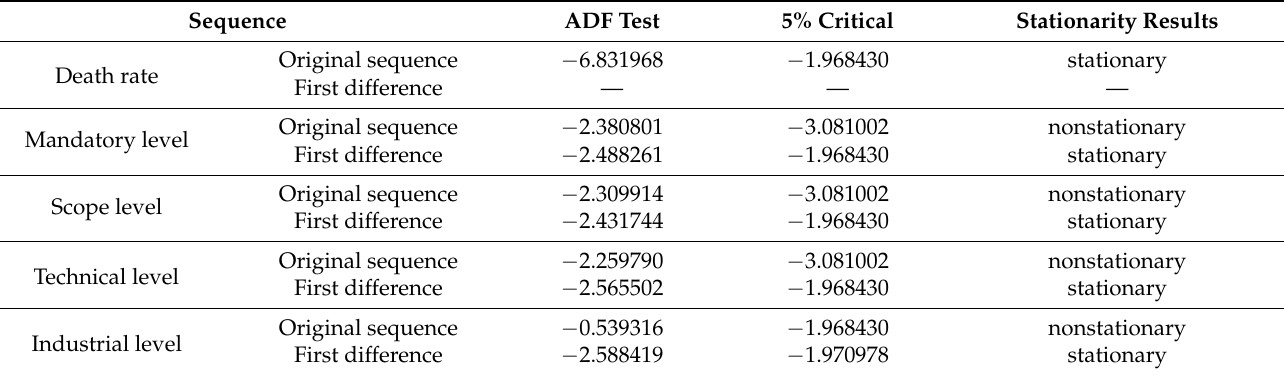
Table 5. Unit root test